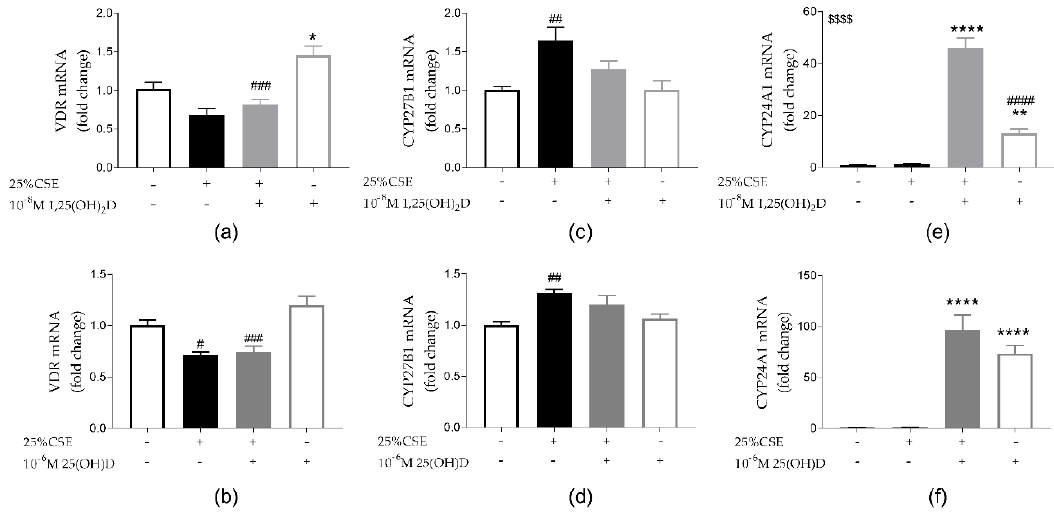
Figure 5. Effect of CSE and vitD on vitD metabolism in 16HBE cells. Both 1,25(OH) 2 D ( a ) and 25(OH)D < 0.05 and p = 0.13 respectively). CSE exposure reduces ( b ) upregulate VDR mRNA expression ( p < 0.05 and p = 0.13 respectively). CSE exposure reduces VDR ( b ) upregulate VDR mRNA expression ( p